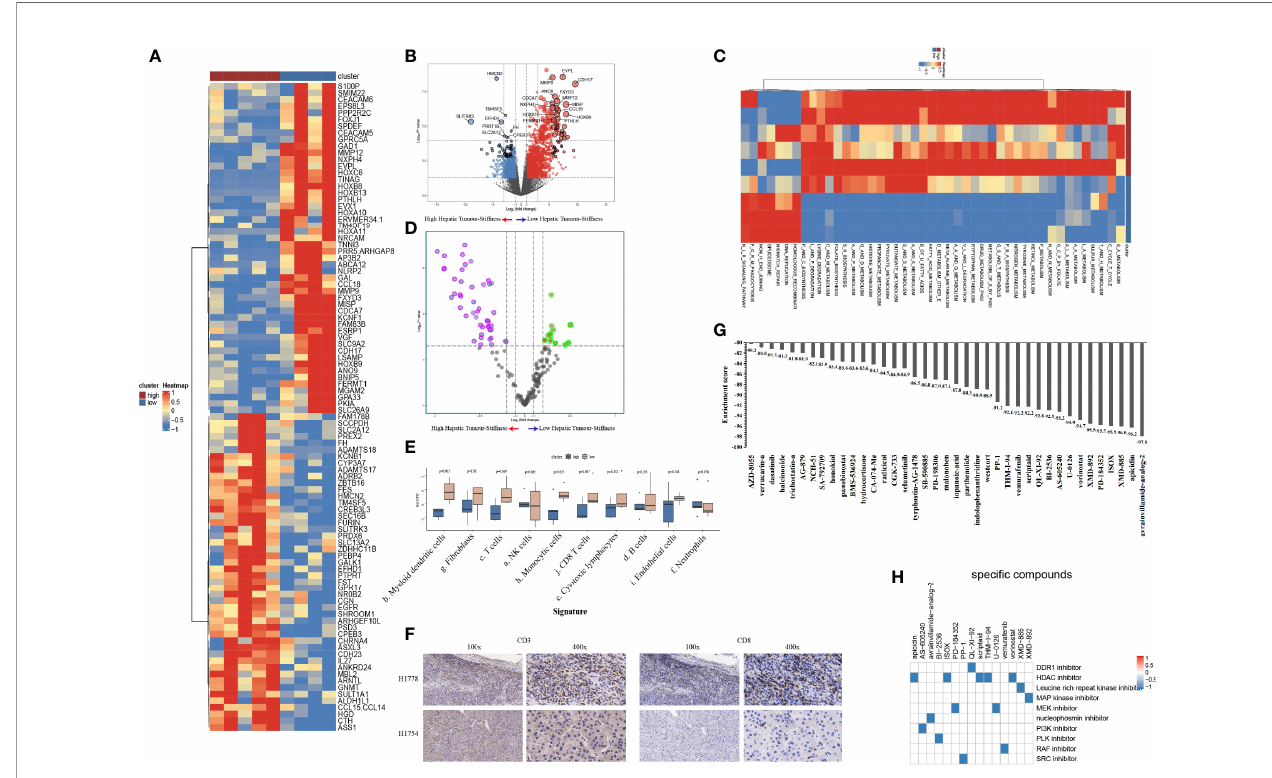
FIGURE 6 | Biological functions and immune characteristics of tumors with high (n = 5) or low (n = 4) stiffness. (A, B) Heatmap (A) and volcano plot (B) comparing differences in gene expression between tumors with high and low stiffness. (C, D) Heatmap (C) and volcano plot (D) comparing differences in Kyoto Encyclopedia of Genes and Genomes (KEGG) pathways between tumors with high and low stiffness. (E) Boxplots of cell in fi ltration levels calculated by the Microenvironment Cell Populations-counter among tumors with high and low stiffness. (F) Representative micrographs of CD3 and CD8 protein expression in tumor samples with high and low stiffness, as detected by immunohistochemistry (H1778 was a patient with low stiffness liver tumor, and H1754 was a patient with high stiffness liver tumor). (G) Bar plot showing the enrichment score of each candidate compound in the connectivity map analysis. Compounds are sorted from right to left as the highest to lowest enriched, as assessed using an enrichment analysis. (H) Heatmap showing the mechanisms of the action (rows) of each compound (columns) from the connectivity map analysis. A total of 15 candidate drugs with absolute connectivity scores of < − 90 were identi fi ed. Among them, 5 were histone deacetylase (HDAC)